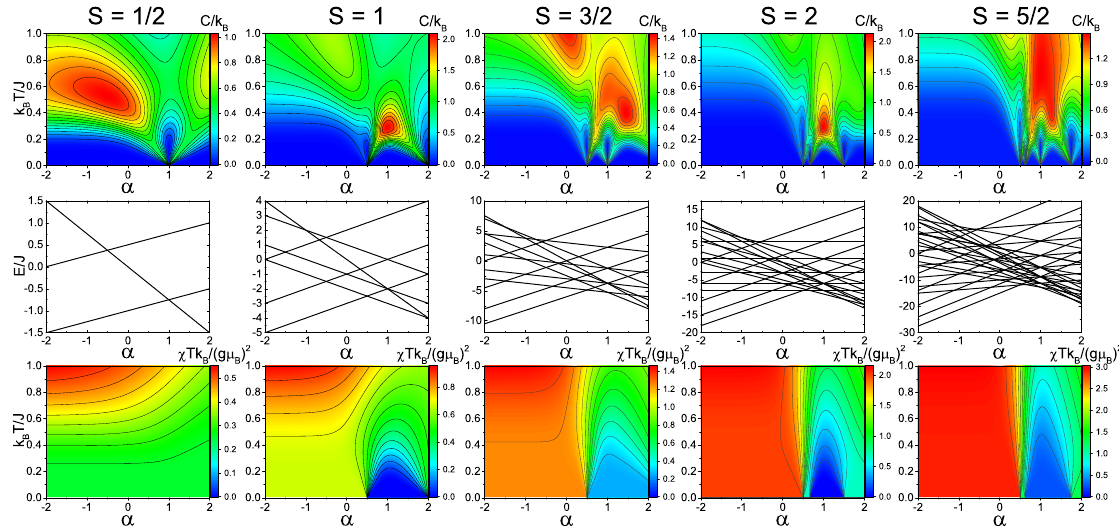
Figure 2. The heat capacity ( top panels), energy levels ( middle panels), and magnetic susceptibility ( bottom panels) for antiferromagnetic ( J = 1) isosceles trimers of spin 1/2, 1, 3/2, 2, and 5/2 as functions of temperature and dimer exchange α .